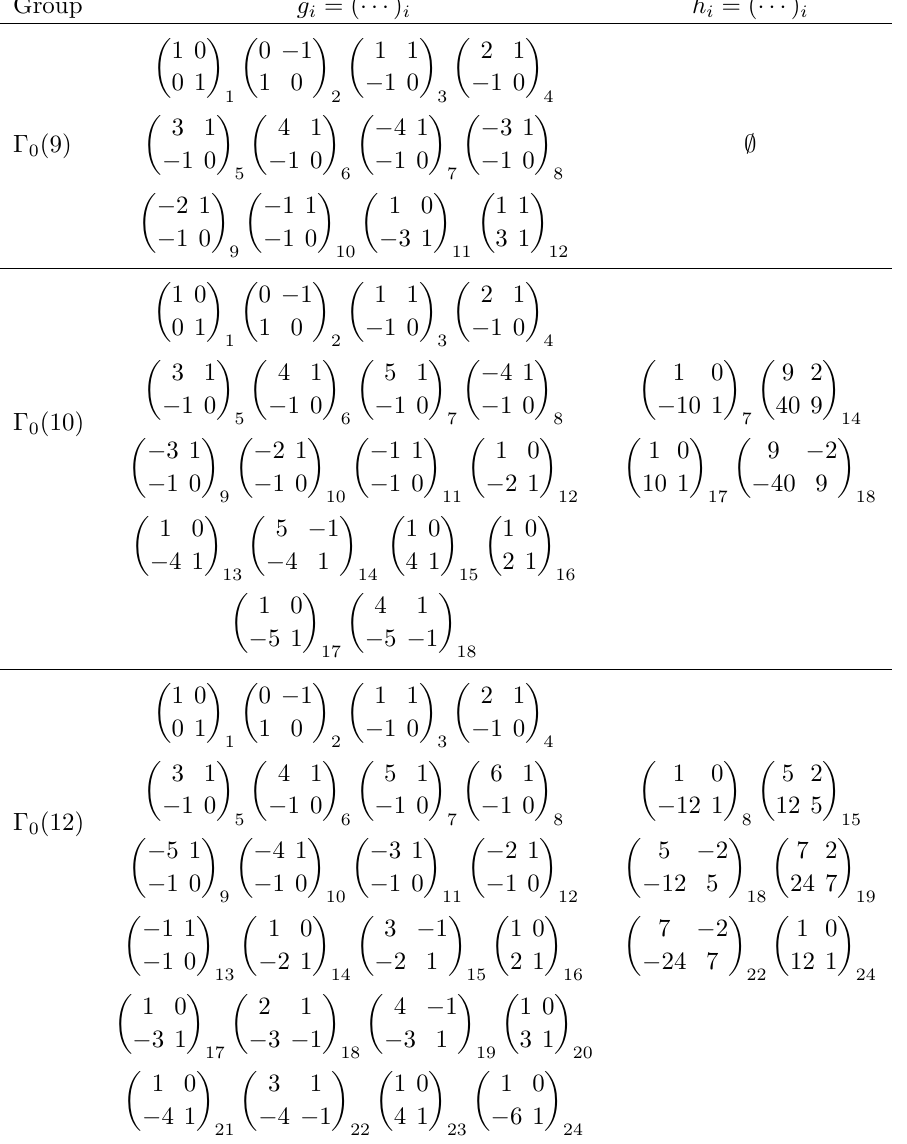
Table 4 . Coset representatives g i and glueing transformations h i for some selected Γ 0 ( N ) , contin-